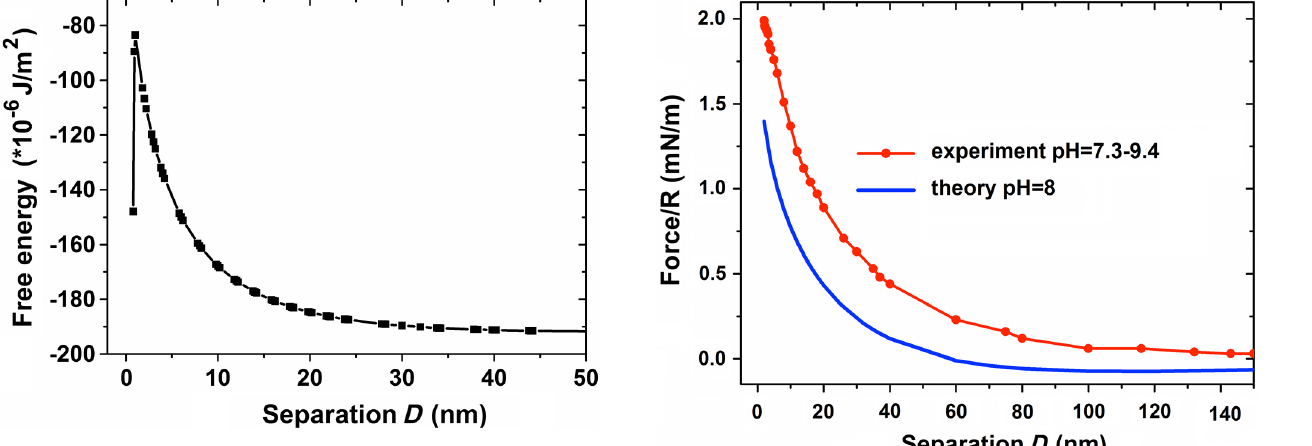
FIG. 8. Comparison between theory prediction and experimen- tally measured force, both plotted as a function of distance for the interaction between a radius ≈ 2 . 5 μ m spherical colloidal particle and Suprasil in 10 − 4 M NaNO 3 of salt solution. Experimental data are from Ref. [122]. The force has been normalized by the sphere radius. Both the range of the force and the absolute value of the force are seen to be in good agreement.